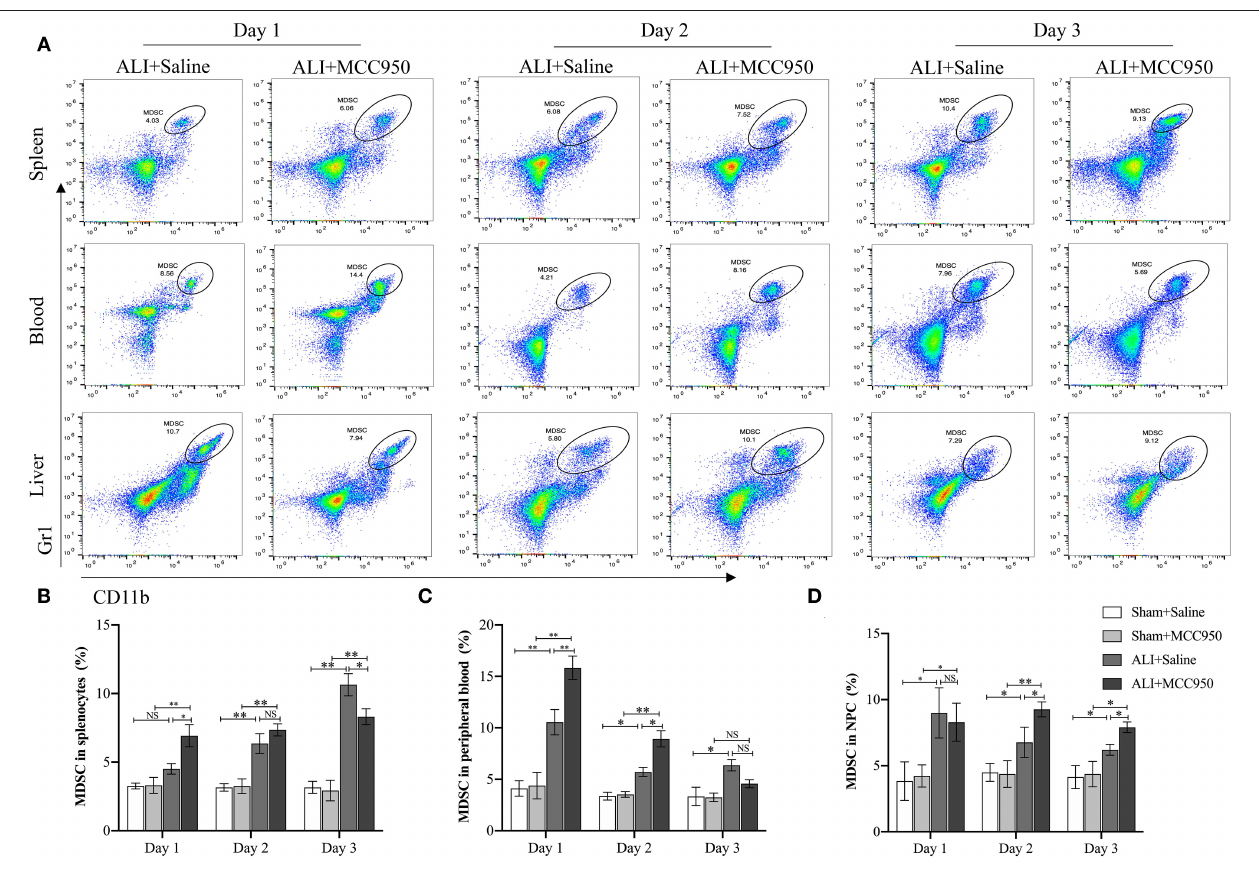
FIGURE 3 | MCC950 treatment enhances myeloid-derived suppressor cell (MDSC) function in acute liver injury. (A) Representative images of MDSC in spleen, blood, and liver detected by flow cytometry in CCl 4 -treated mice pretreated with vehicle or MCC950 on days 1, 2, and 3. MDSC was marked as CD11b + Gr-1 + . (B) Time points of MDSC percentages in spleen. (C) Time points of MDSC percentages in peripheral blood. (D) Time points of MDSC percentages in liver. Data are presented as mean ± SEM. NS: No significance. * p < 0.05, ** p < 0.01. Intergroup differences are determined by the Student’s t